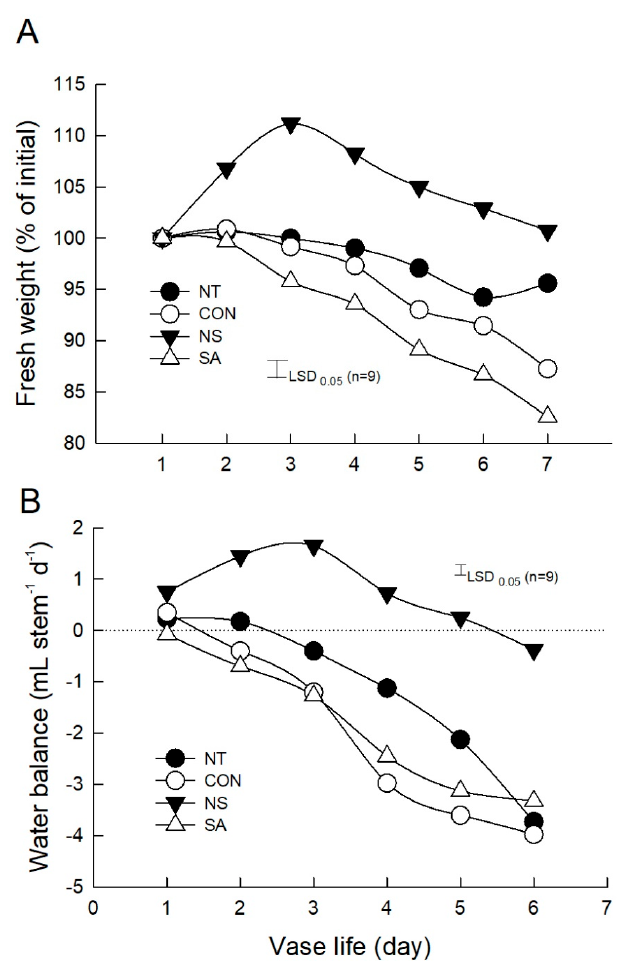
Figure 5. Effect of B. cinerea infection on initial fresh weight ( A ) and water balance ( B ) of cut roses. NT, non-treated flowers; CON, flowers were held in distilled water; NS and SA, cut flowers were treated with nano silver and salicylic acid. CON, NS, and SA flowers were sprayed with B. cinerea conidial suspension to induce gray mold development. All flowers were then stored at 10 ± 2 °C and 80–90% RH in dark conditions for 4 d for export simulation. Data were presented as the mean ± standard errors ( n = 9).